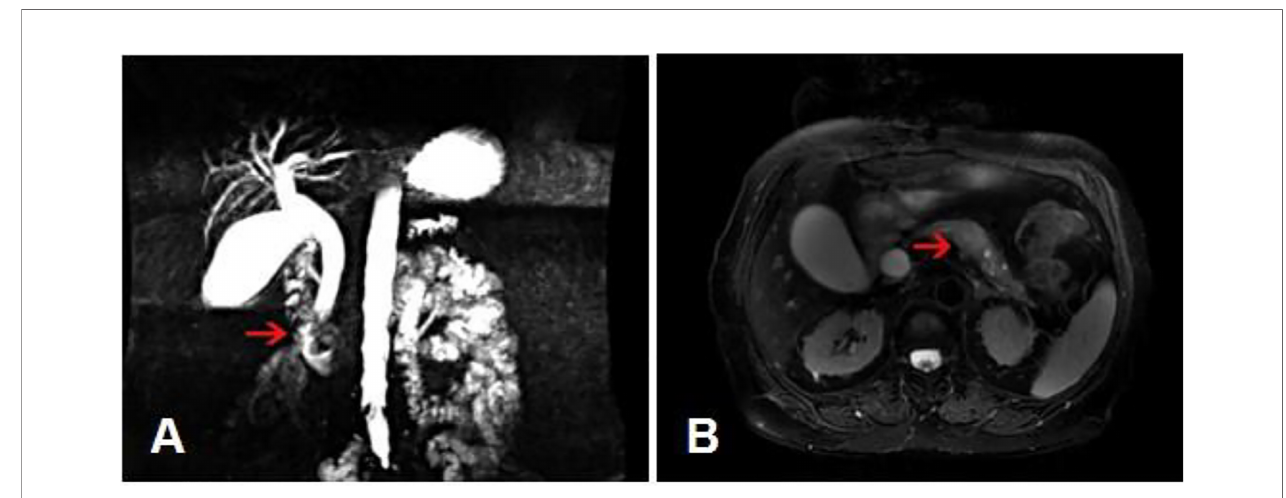
FIGURE 2 | MRCP results. (A) A soft tissue nodule at the end of the common bile duct with low biliary tract obstruction. (Arrow: the location of the tumor). (B) A poorly de fi ned somatic nodule at the body of the pancreas. (Arrow: the location of the